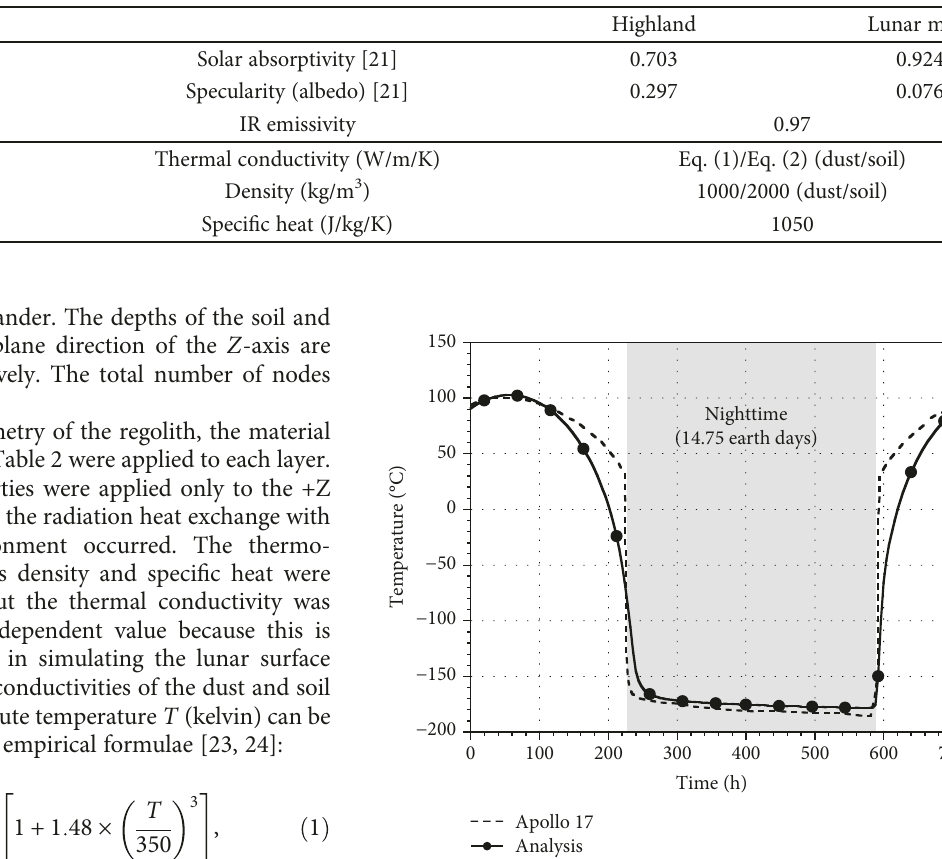
Figure 3: Comparison between the lunar surface temperatures of the analysis and Apollo 17